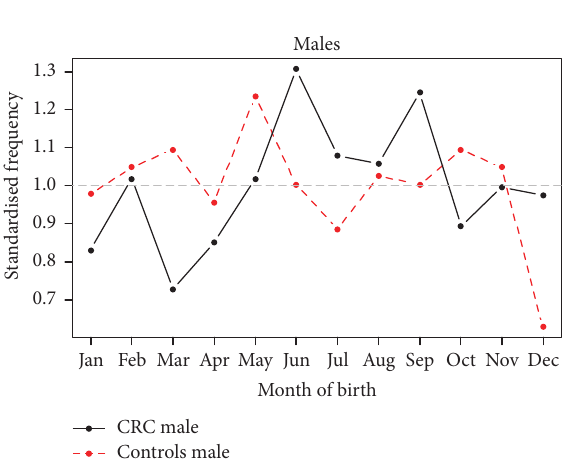
Figure 2: Detrended monthly seasonal components as a fraction of their mean for CRC. The trough (March) and the peak (September) of the seasonal component are similar to the Poisson model at 14% ( p = 0.06).